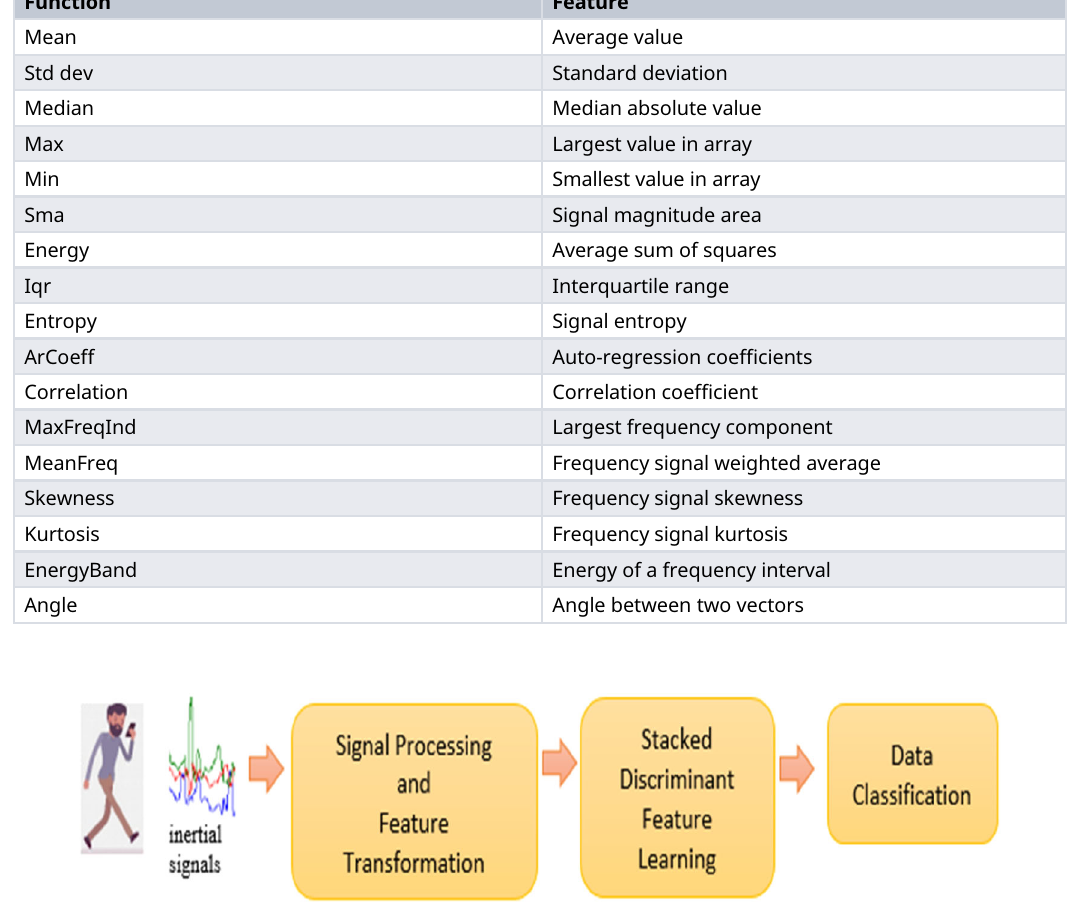
Figure 1. Overview of the proposed Stacked Discriminant Feature Learning (SDFL) system.